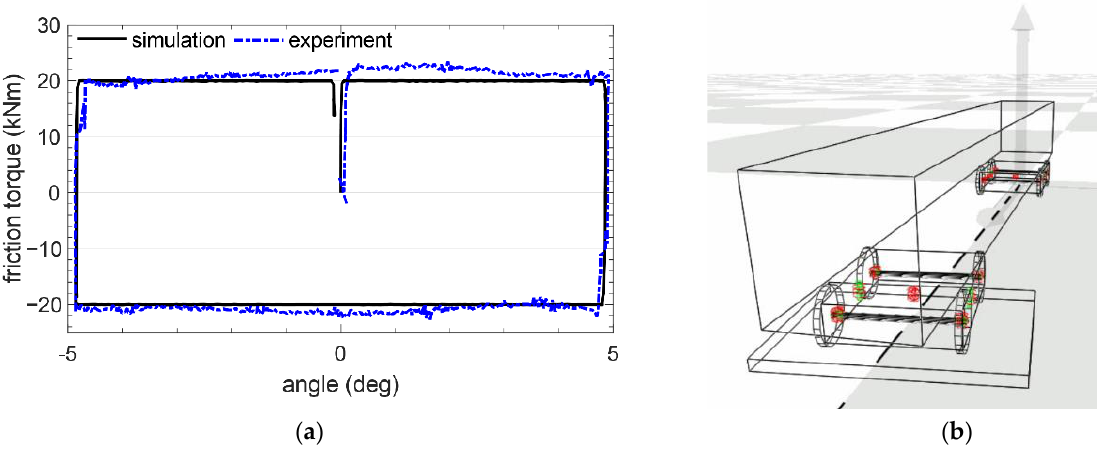
Figure 3. ( a ) An example of characteristics of the friction torque between the boogie and the loaded wagon body as a function of the angle of bogie rotation with respect to the vertical axis (measuring angular speed ω = 1°/s) ( b ) View of the vehicle model during rotation of the bogie.